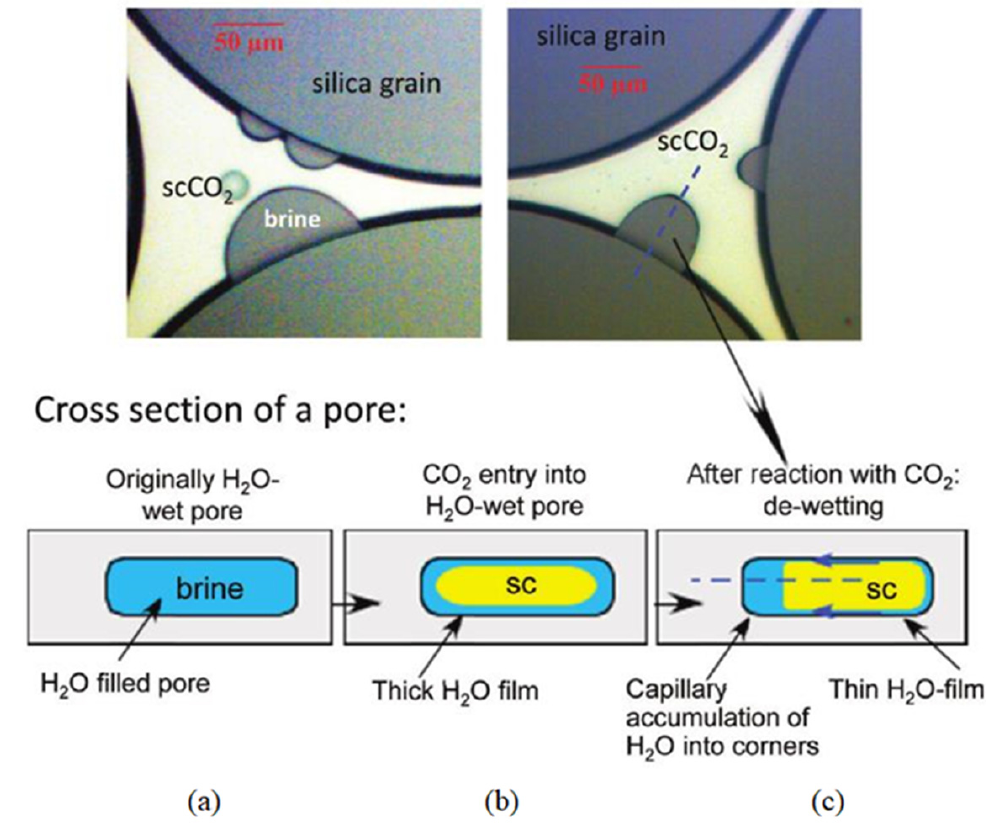
Figure 4. Schematic of water film thinning process due to CO 2 injection in porous media [37]. ( a ) brine filled pore; ( b ) CO 2 entry into pore; ( c ) reaction induced water film thinner. (Reprinted with permission from [37]. Copyright 2012 American Chemical Society).